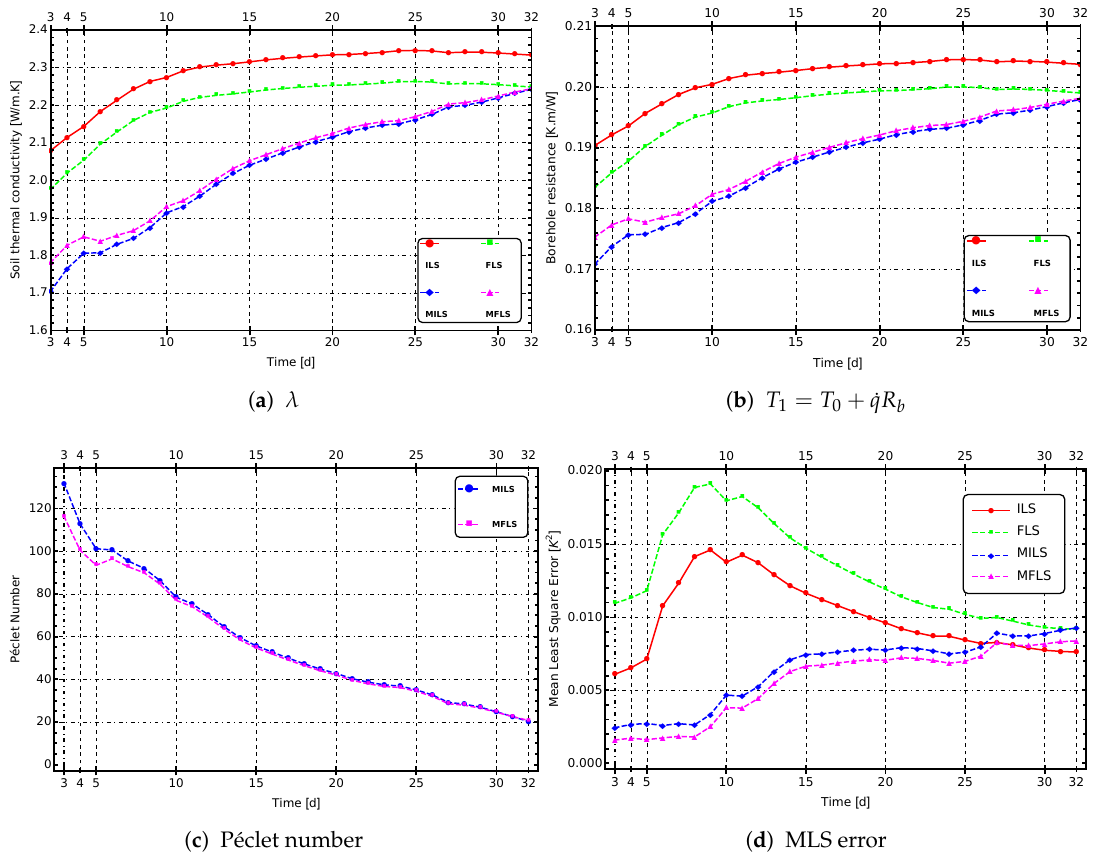
Figure 3. Comparison of the evolution of the parameter estimates when the number of days of the experiment is increased for each of the four different models. The data are taken from test_2_25. In ( a ) soil conductivity ( λ ), in ( b ) the borehole resistance estimation ( T 1 = T 0 + ˙ qR b ), and in ( c ) the Péclet number estimation (only for the two models that use this value). The mean least square error between theoretical models and measured data for the four different models is shown in ( d ). The legends are the same in the four